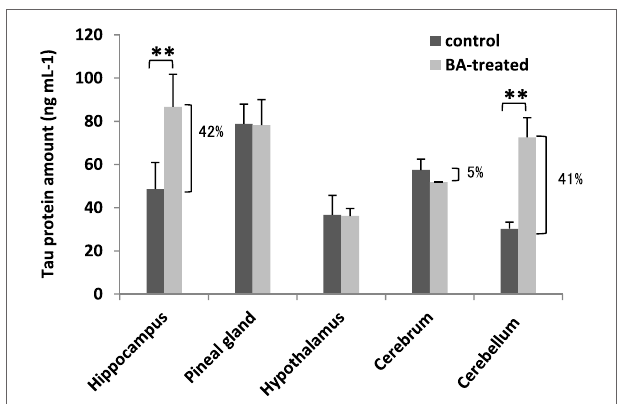
FigUre 6 | Brain tau protein amounts are affected by gingival periodontal disease level-butyric acid (BA). Measurement of brain tau protein amounts is indicated. Results shown are mean ± SE utilizing independent brain samples (hippocampus, pineal gland, hypothalamus, cerebrum, and cerebellum) of 10-week-old Wistar male rats ( n = 6). Control and BA-treated (12 h post-treatment) rats were used. Statistical analyses were performed using Anderson–Darling normality test and, if passed ( p > 0.05), Student’s t -test (** p < 0.01). Percent difference between control and BA-treated rats are